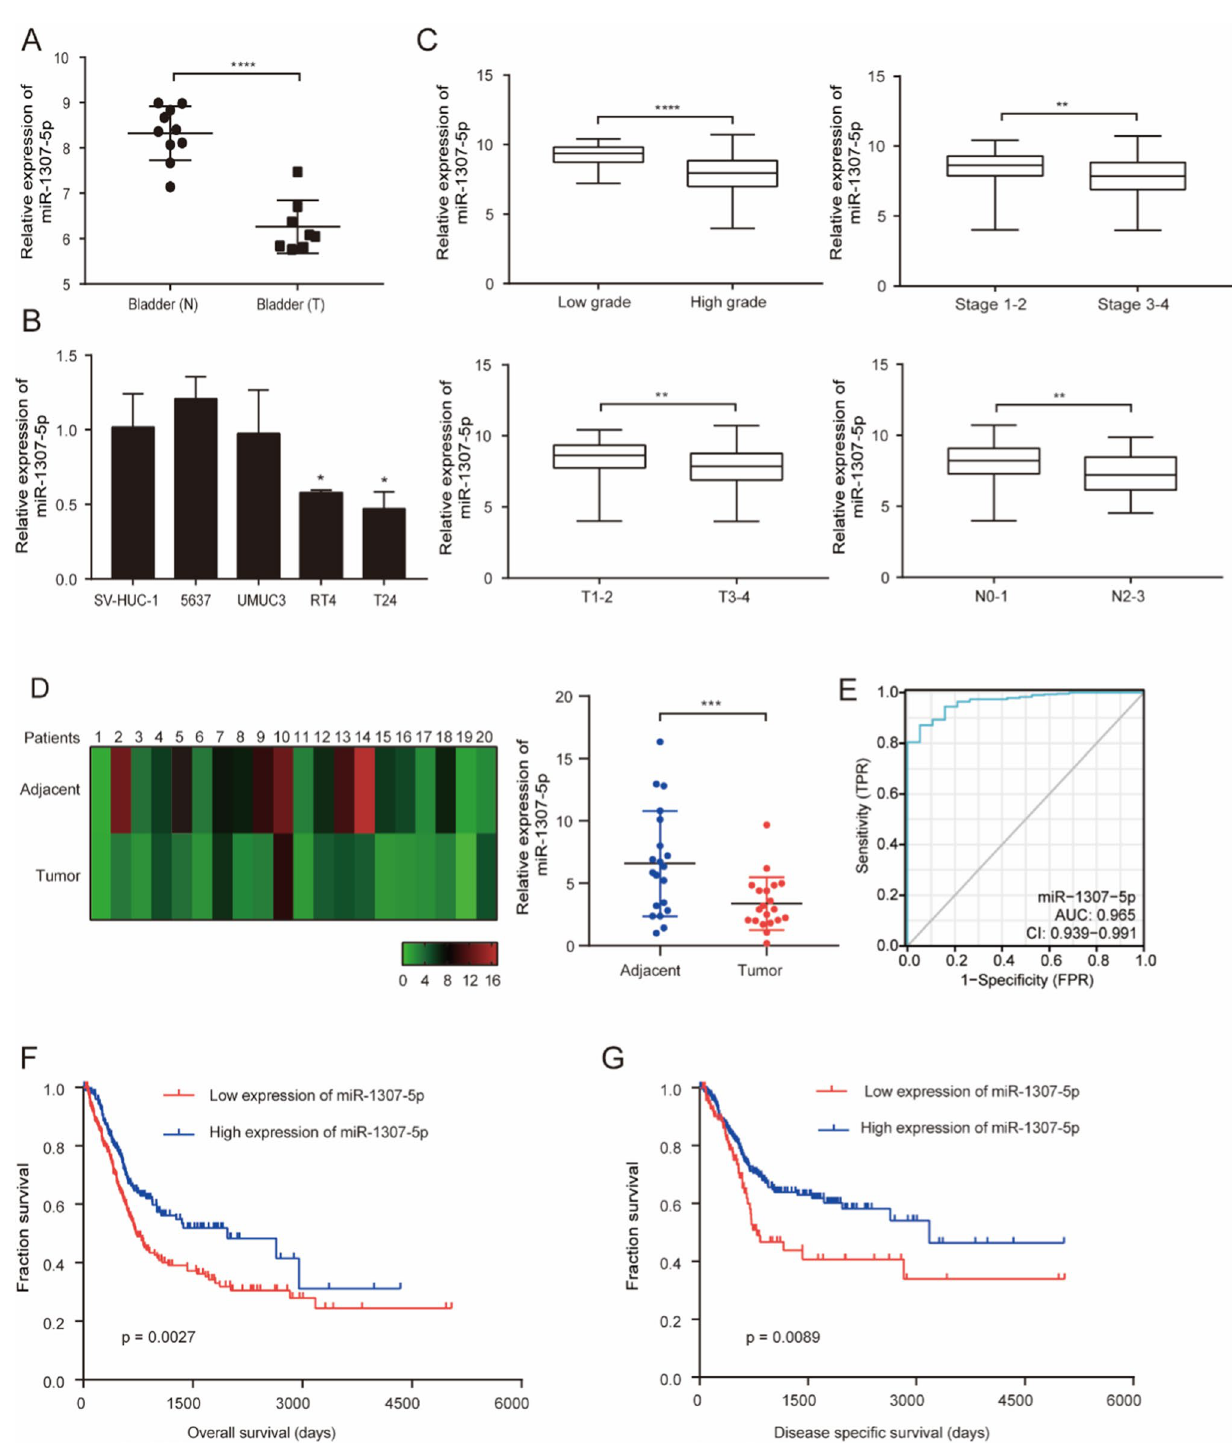
Fig. 1 Inverse correlation between miR-1307-5p expression and—bladder cancer clinical grades. A Expression levels of miR-1307-5p in clini- cal bladder cancer tissues versus normal bladder tissues, based on analysis of the GEO datasets. B Expression levels of miR-1307-5p in blad- der cancer cell lines and a normal human bladder uroepithelium cell line was determined by RT–qPCR. C Loss of miR-1307-5p coincide with worse clinicopathological features, as analysis of the TCGA datasets. D miR-1307-5p expression in 20 paired bladder tumor tissues versus adjacent normal tissues. E RT–qPCR analysis—of miR-1307-5p in tumor tissues and matched normal tissues. F Kaplan–Meier’s analysis of clinical cases based on miR-1307-5p expression and overall survival rates. G Kaplan–Meier’s analysis of clinical cases based on miR-1307-5p expression and disease specific survival rates. *p < 0.05; **p < 0.01; ***p < 0.001; ****p < 0.0001. Data depicts the mean ± standard deviation and are representative of three independent experiments. TNM means tumor node metastasis. Low grade means part of grade 1 carcinomas and part of grade 2 carcinomas, High grade means part of grade 2 carcinomas and grade 3